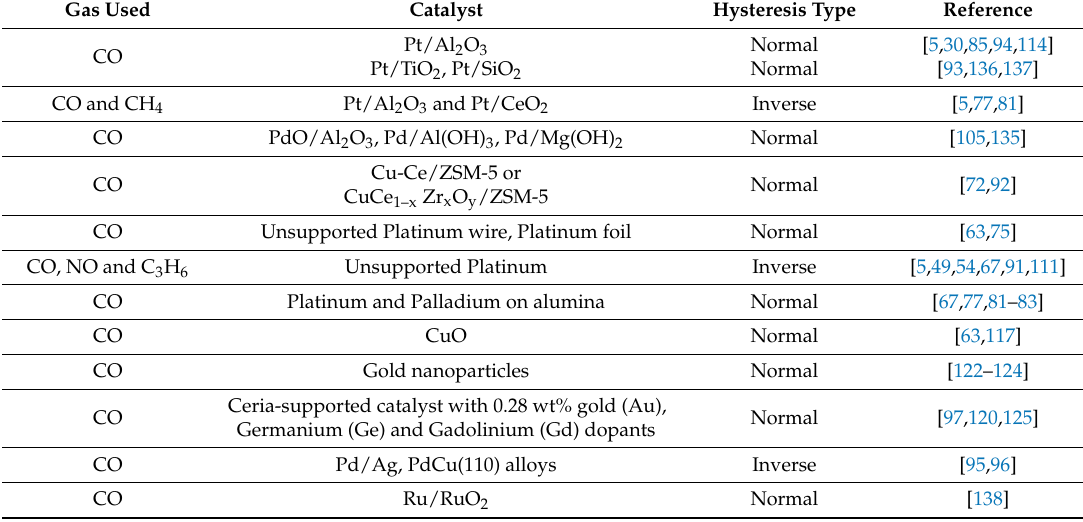
Table 1. Summary of the critical experiments which exhibited hysteresis.